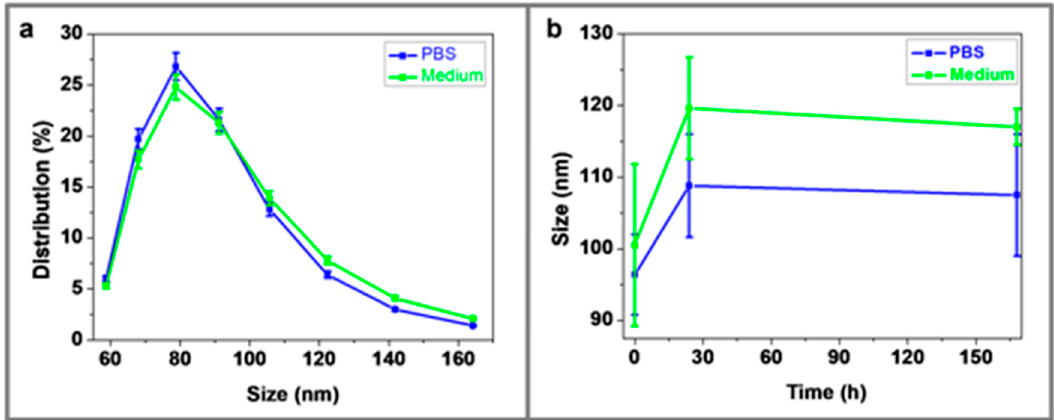
Figure 5. ( a ) Histogram of Dynamic Light Scattering (DLS) sizes in Phosphate Buffered Saline (PBS) (blue) and cell growth medium (green); ( b ) hydrodynamic diameters of magnetic NPs vs time at 37 °C in PBS buffer (blue) and cell growth medium (green).